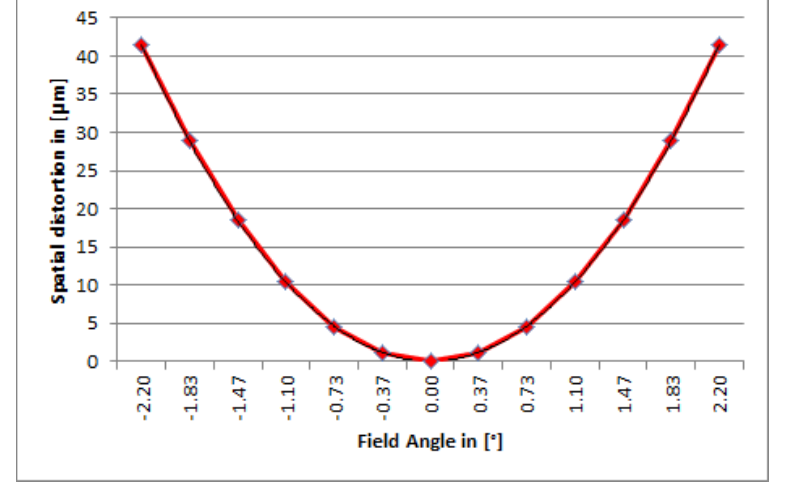
Figure 6. Smile effect @ 700nm.